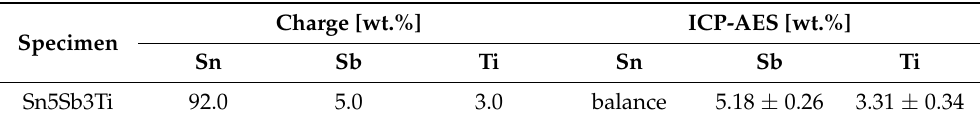
Table 1. Chemical composition of soldering alloy type Sn-Sb-Ti and the results of chemical analysis performed by ICP-AES method.